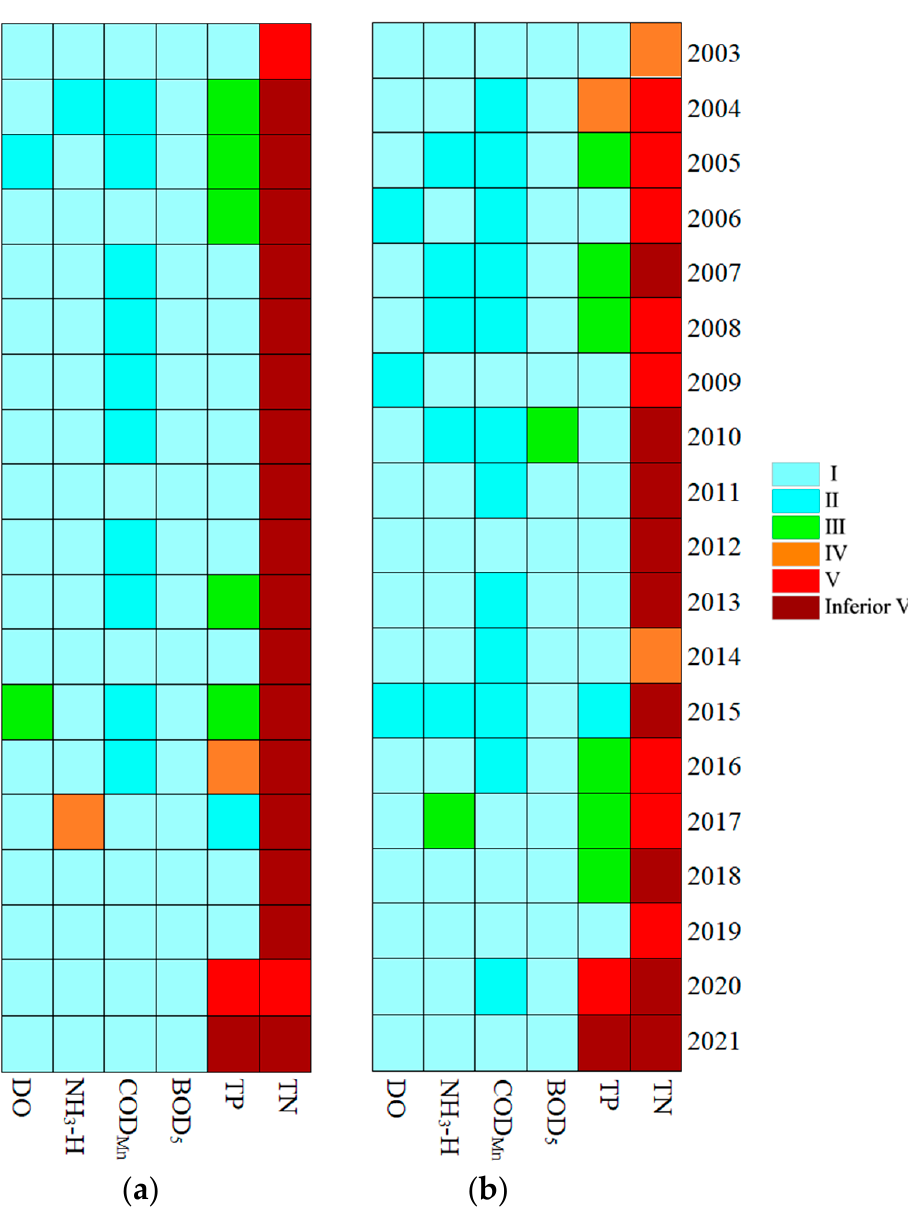
Figure 7. Water quality evaluation results for each indicator of the Taigou section from 2003 to 2021. ( a ) low water period (May), ( b ) high water period (September).